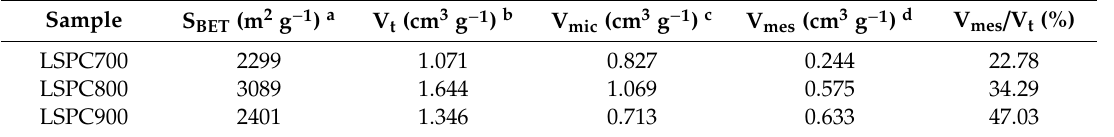
Figure 5. ( a ) N 2 adsorption and desorption isotherms and ( b ) pore size distribution of the LSPCs. Table 2. Pore structure parameters of the Table 2. Pore structure parameters of the LSPCs.